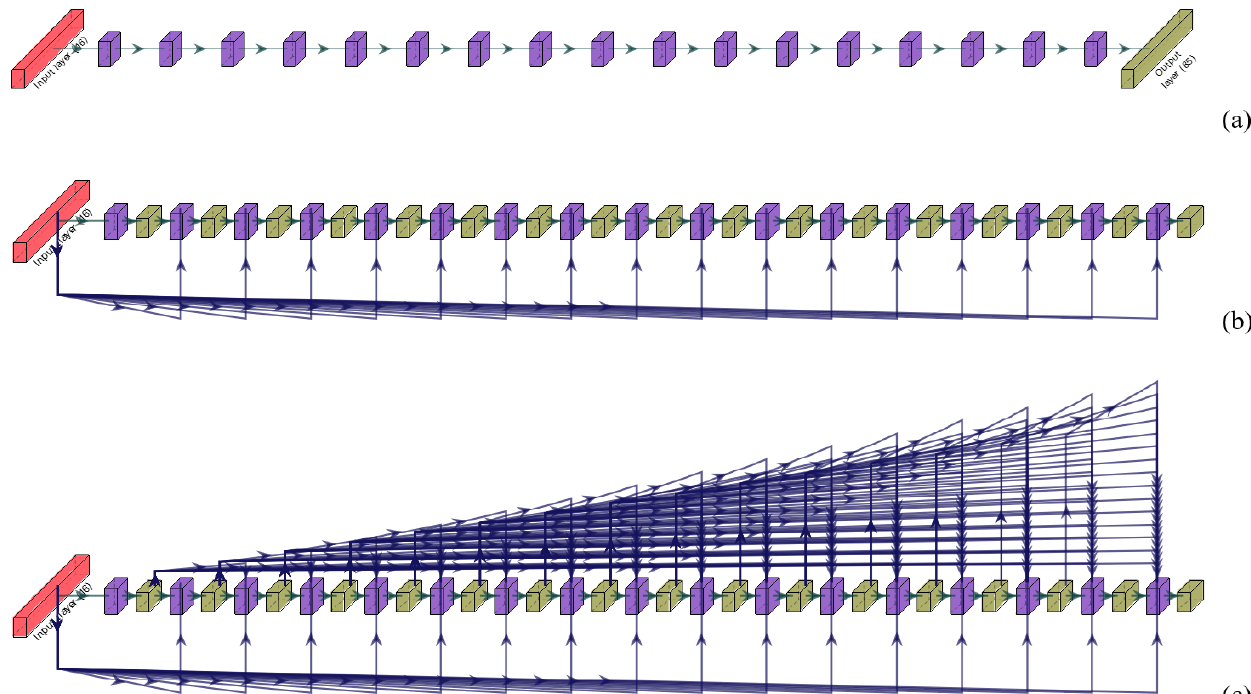
Figure 1. Three variants of DNN developed in this study. Red, yellow, and purple indicate the input layer (16 near-surface variables), output layers, and hidden layers, respectively. (a) Fully connected feed-forward neural network (FFN), which has only one output layer with 85 variables (five variables for each of the 17 WRF model vertical levels), and 17 hidden layers which only consider the near-surface variables as inputs. (b) Hierarchically connected network with previous layer only connection (HPC), which has 17 output layers (corresponding to the PBL levels) with each of them having five variables, and 17 hidden layers with each of them considering both near-surface variables and five output variables from previous output layer as inputs. (c) Hierarchically connected network with all previous layers connected (HAC); same as HPC, but each hidden layer also considers output variables from all previous output layers as